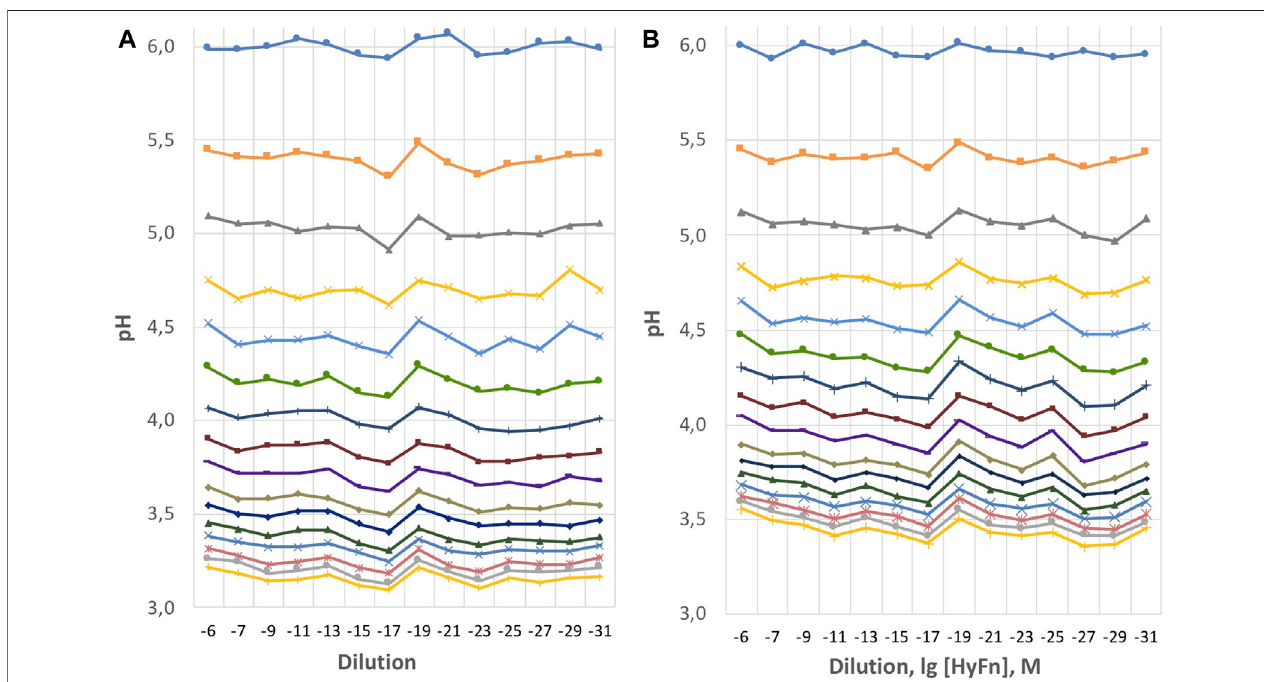
FIGURE2| VariabilityofpHvaluesin (A) “ dilutions ” ofwaterand (B) HyFndilutionsduringsequentialtitrationofthesamples.Averagevaluesfor6seriesofsamples are presented. Each horizontal line represents pH values in the dilutions after HCl injections were made. Successive injections are accompanied by increased acidi fi cation, and each next line is lower than the previous one. Abscissa depicts sequential dilutions of HyFn or of water “ dilutions ” corresponding to calculated lg [HyFn], M.